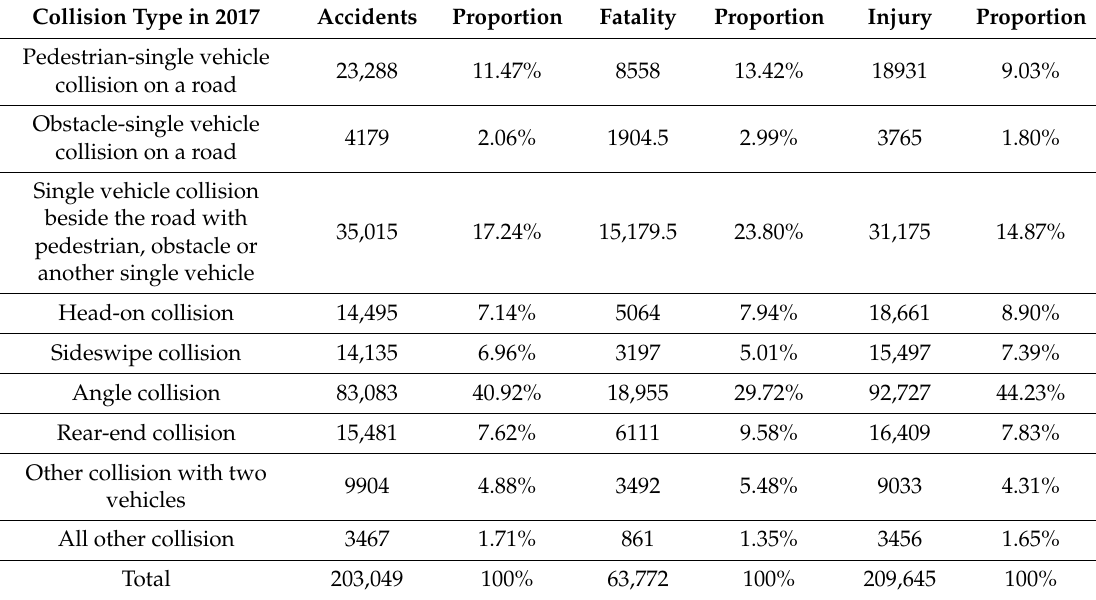
Table 1. The proportion and the number of injuries and fatalities in China’s collisions